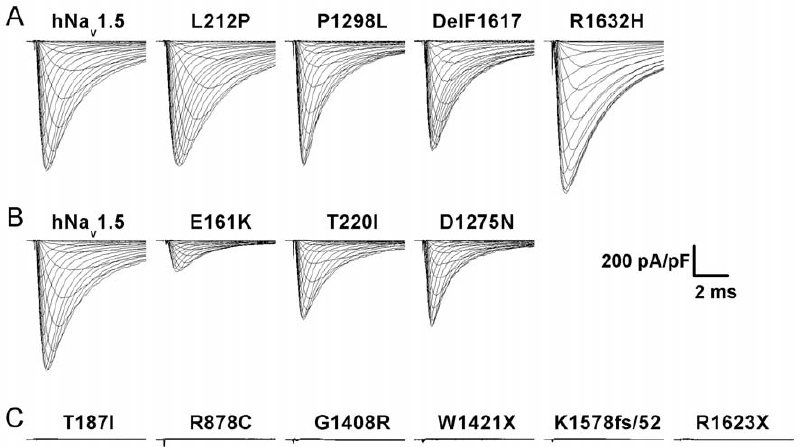
Figure 1. Representative HEK293 whole-cell current recordings for hNa v 1.5 and SSS-associated mutants. (A) Group 1 mutants produced peak current densities similar to wild-type hNa v 1.5. (B) Group 2 mutants produced reduced currents. (C) Group 3 mutants produced no current. Table 1 shows average peak current densities and statistics thereof.